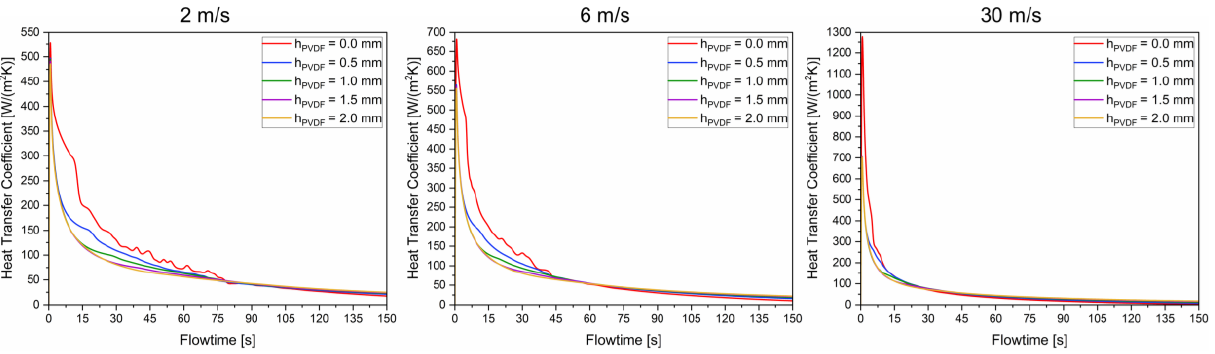
Table 3. Heat accumulation during the heating process of the core shell particle.